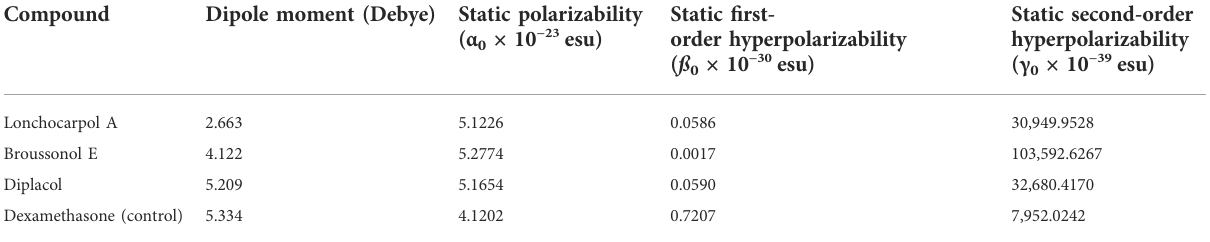
TABLE 4 Molecular electric dipole moment ( µ ), static polarizability ( α 0 ), static fi rst-order hyperpolarizability ( ß 0 ), and static second-order hyperpolarizability ( γ 0 ) of the top four compounds.